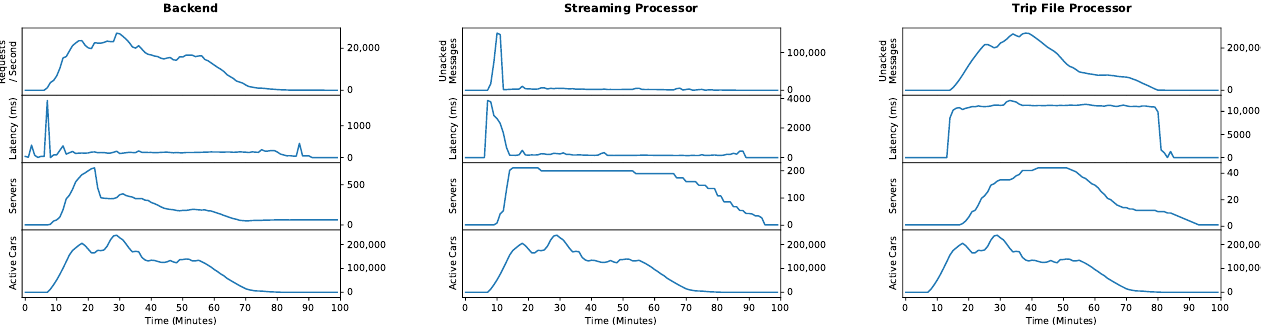
Figure 11. Results of a performance evaluation that was conducted by simulating over 200,000 concurrent cars. Performance metrics have been recorded for each of our infrastructures. It can be seen that the applied load causes an initial latency spike on the App Engine and Streaming infrastructure. This results from the rapidly increasing load for which insufficient capacity is available at this moment. The latency returns to normal after the capacity was automatically increased. It remains continuously low and thus enables time critical processing operations even at peak load. The latency of the Trip File Processor is elevated but stays on the same level. Its operations are not considered to be time critical. Thus, we have applied a less aggressive scaling strategy.